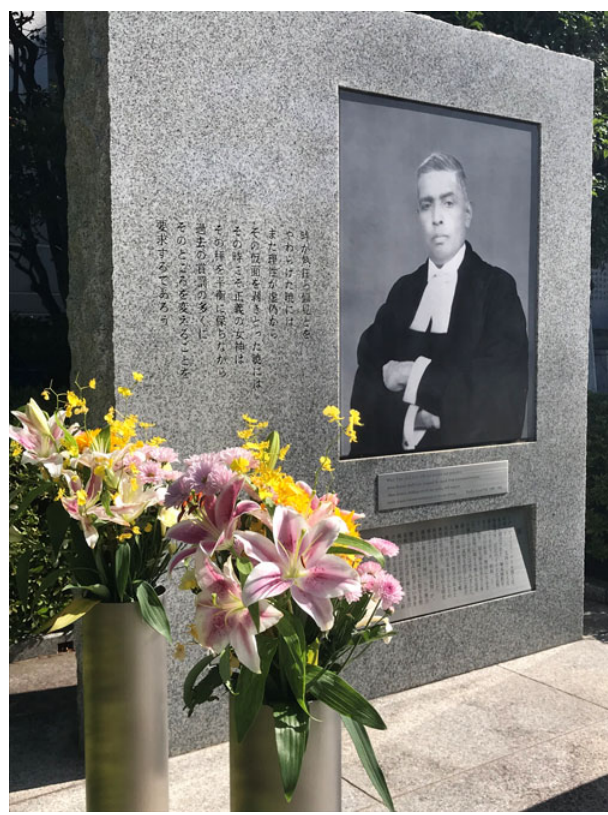
FIG. 1: Memorial to Judge Pal. Photograph taken by the author on July 2, 2018.